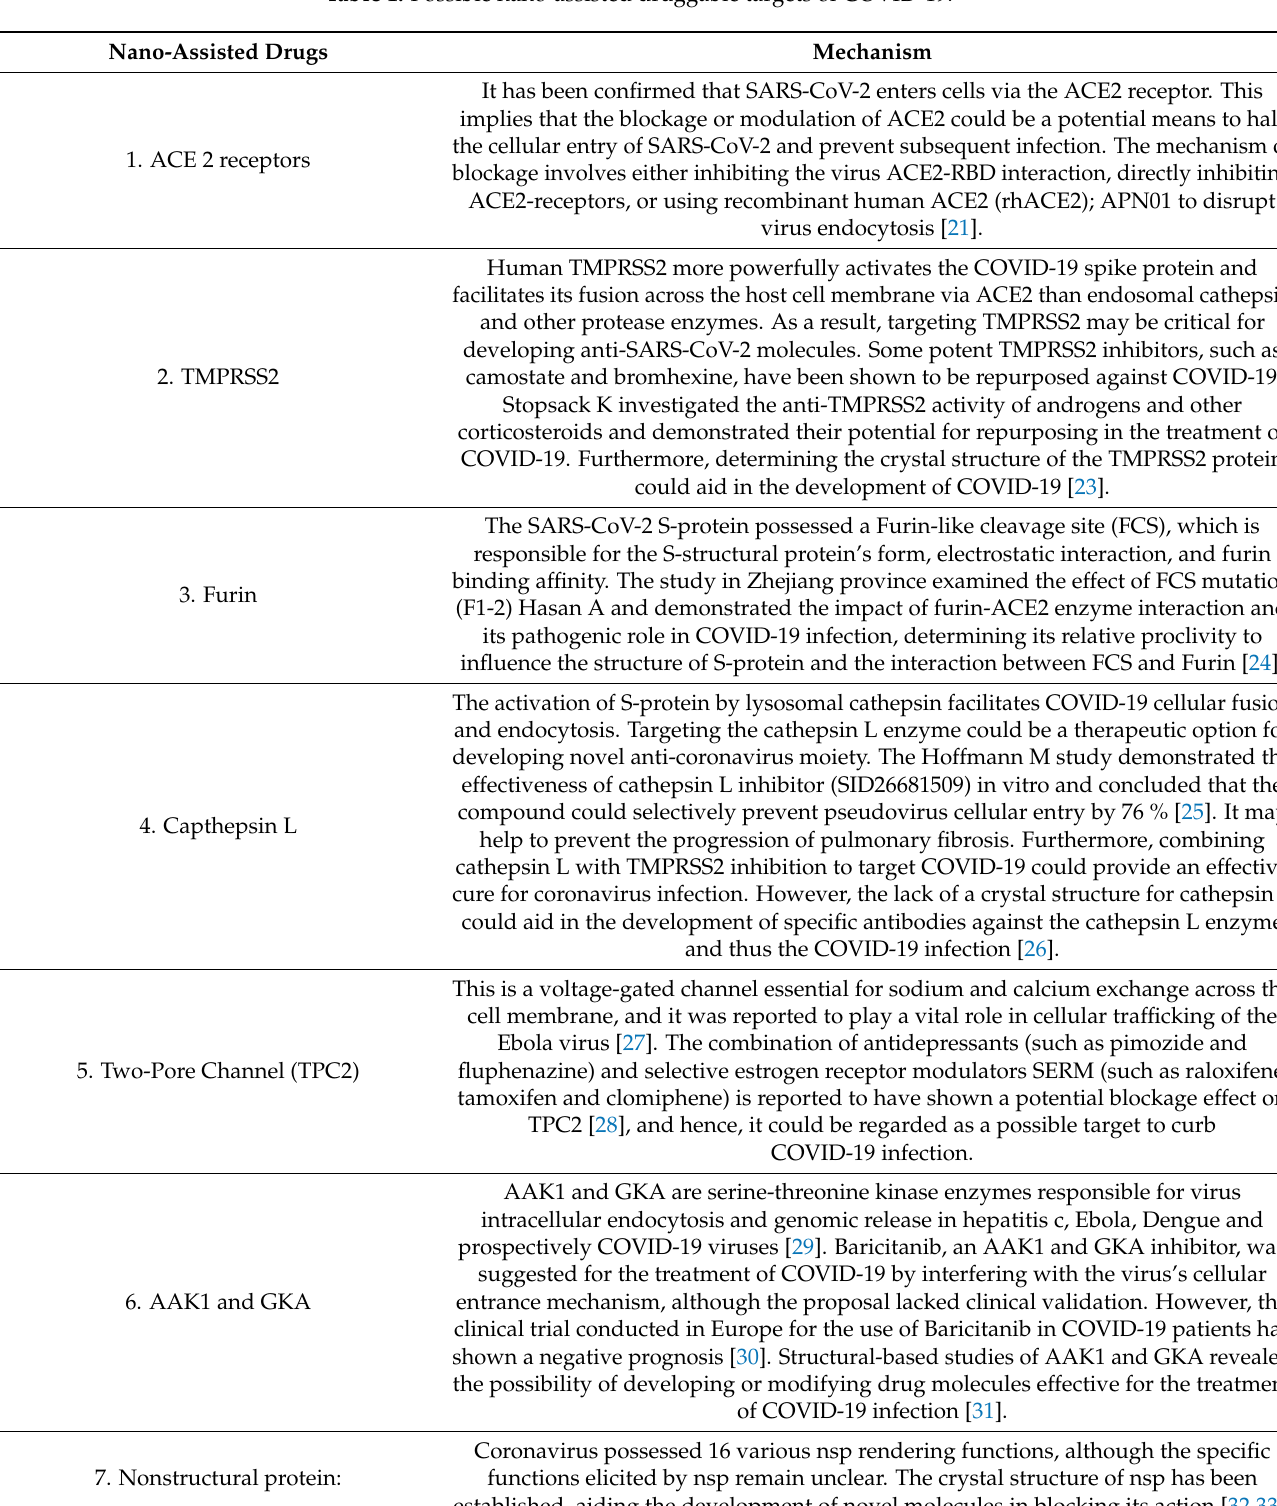
Table 1. Possible nano-assisted druggable targets of